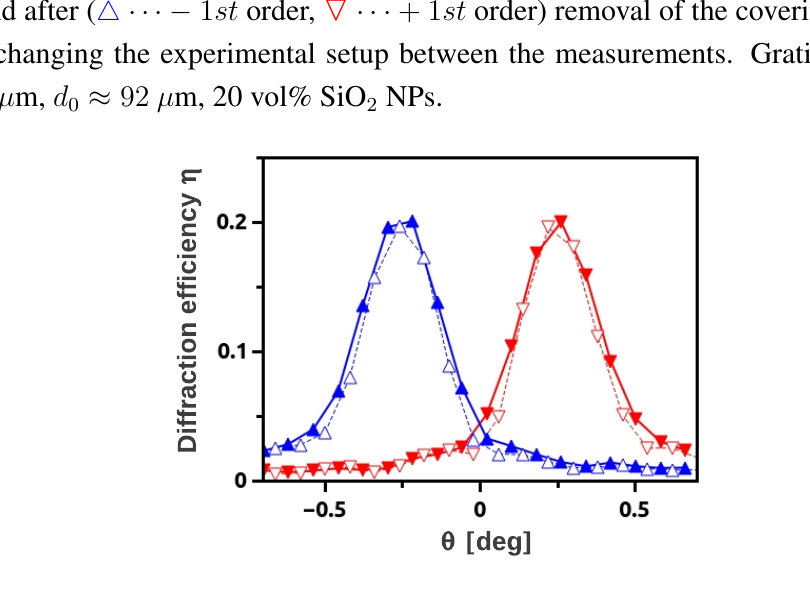
2 ; and (b) θ = θ B B